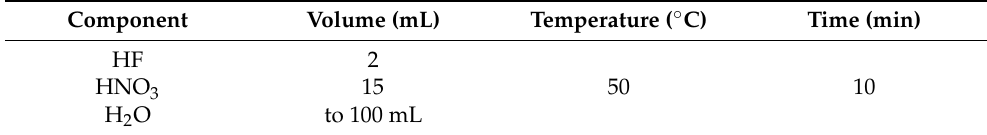
Table 3. Conditions of pickling [18]. Table 2. Conditions of the electrochemical etching (ASTM A262, A practice).